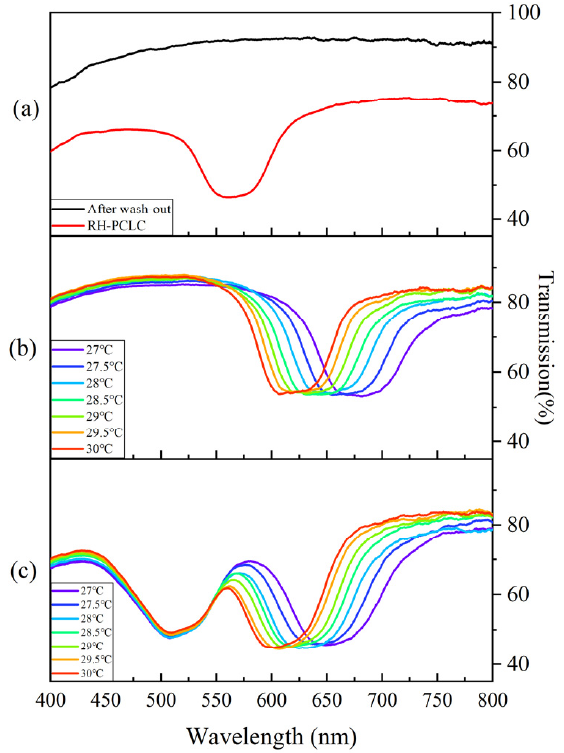
Figure 4. Transmission spectra ( a ) Sample B (red line), Sample C (black line), ( b ) the LH ‐ CLC in a traditional liquid crystal cell (Sample E) at different temperatures, and ( c ) Sample D at different temperatures.